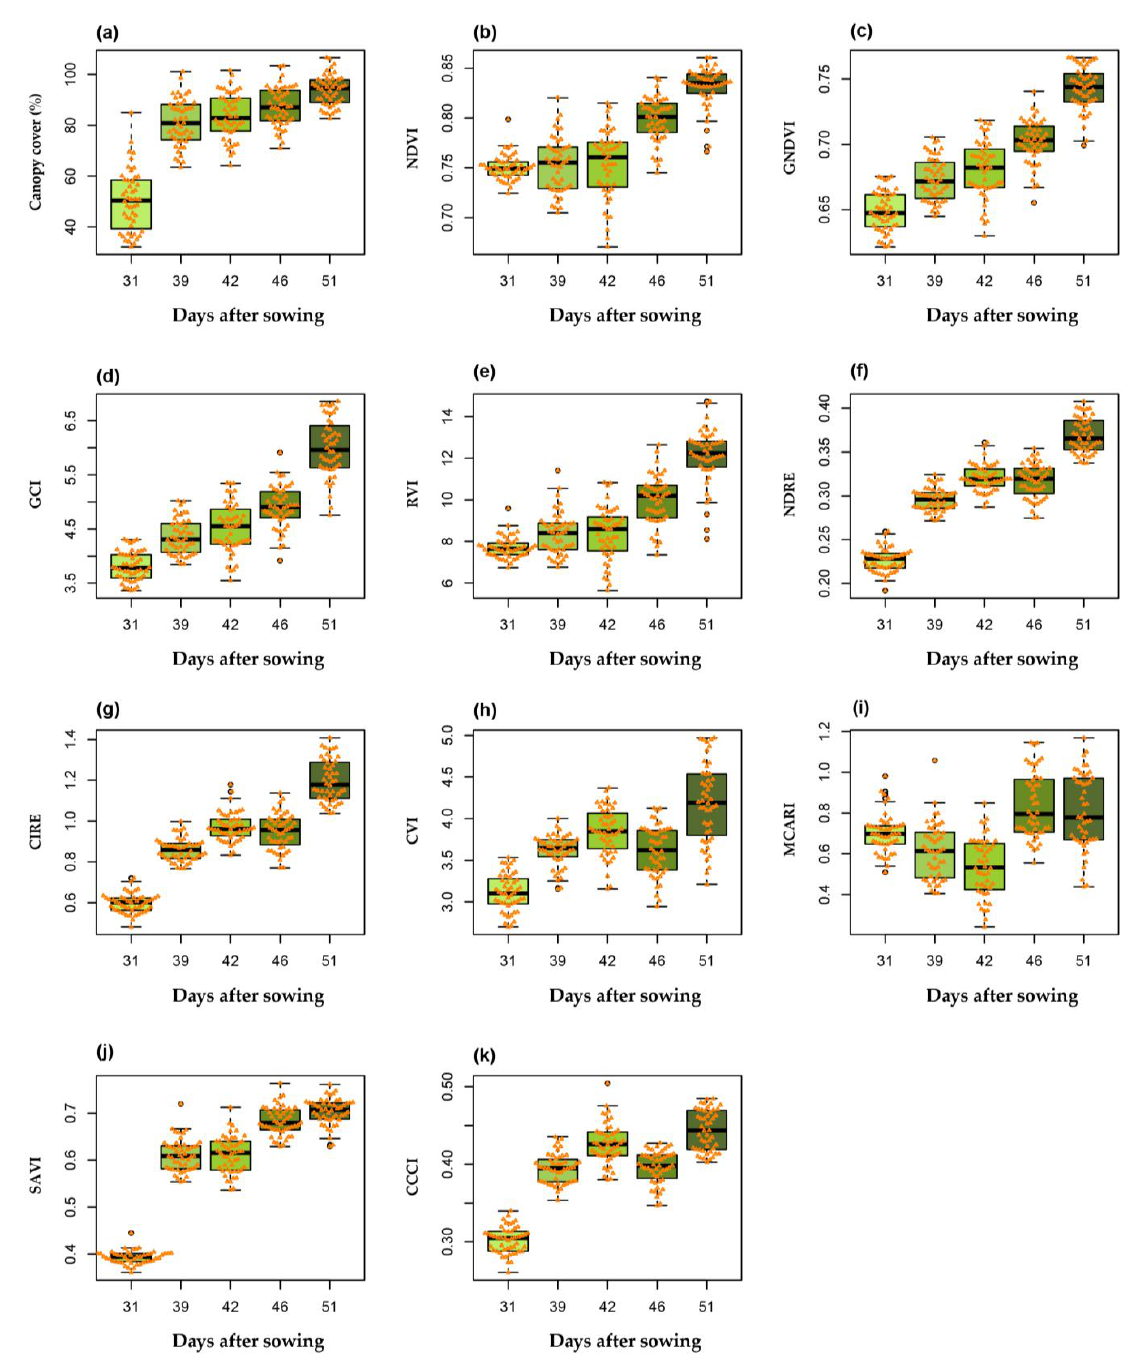
Figure 3. Comparison of canopy cover according to DAS and vegetation indices: ( a ) Canopy cover; ( b ) NDVI; ( c ) GNDVI, ( d ) GCI; ( e ) RVI, ( f ) NDRE; ( g ) CIRE, ( h ) CVI; ( i ) MCARI; ( j ) SAVI; ( k ) CCCI.